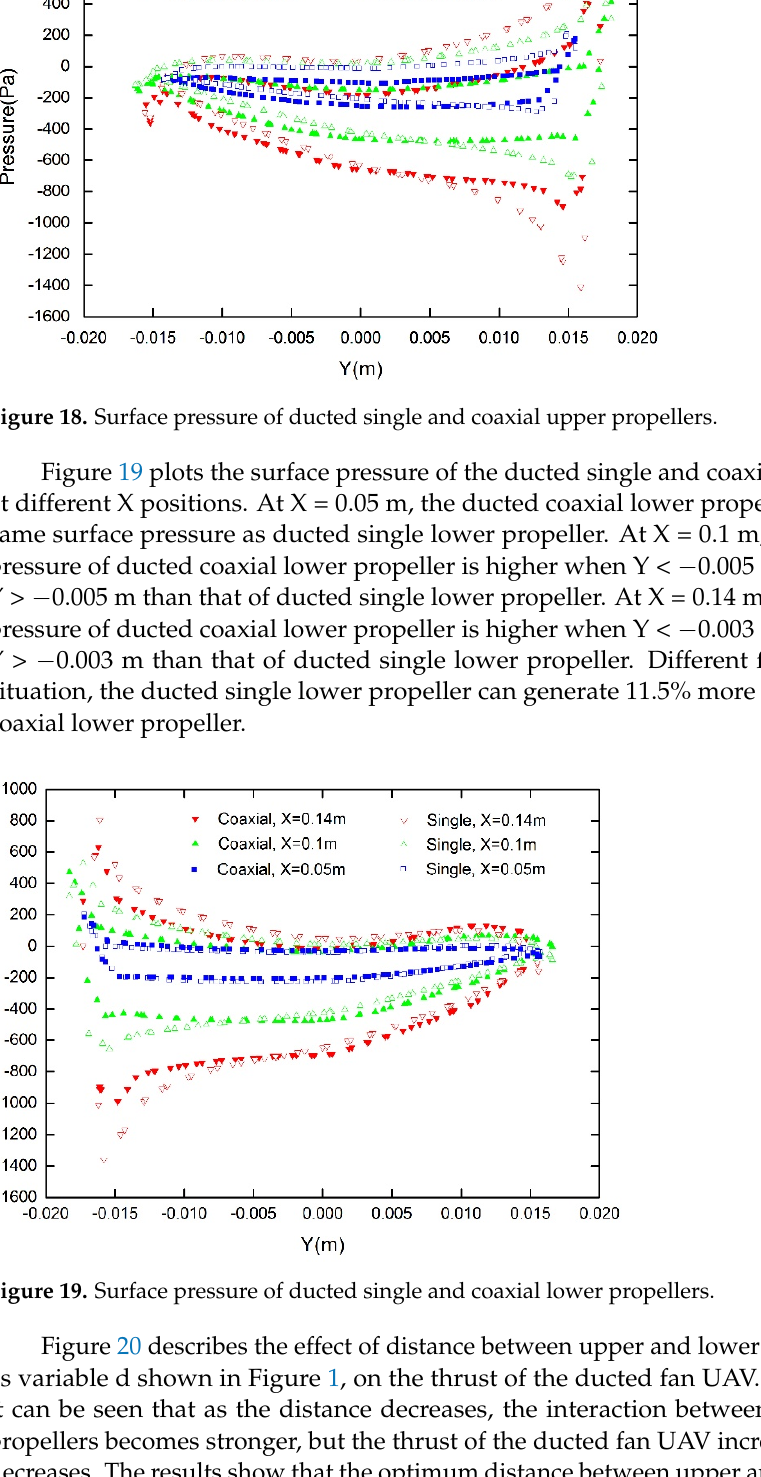
Figure 19. Surface pressure of ducted single and coaxial lower propellers.